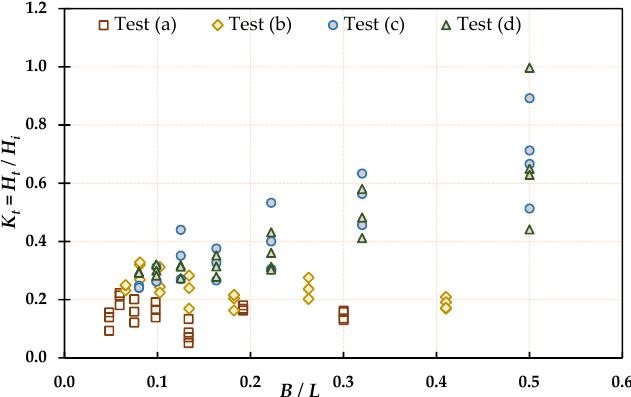
Figure 8. Transmission coefficient ( 𝐾 (cid:3047) ) versus relative crest width ( 𝐵 L⁄ ) .